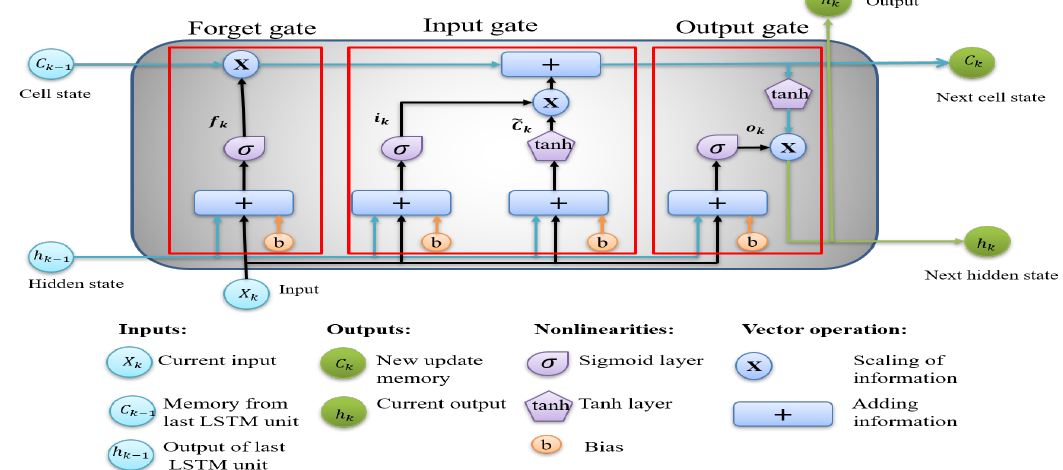
Figure 8. Basic structure of an Long Short Term Memory